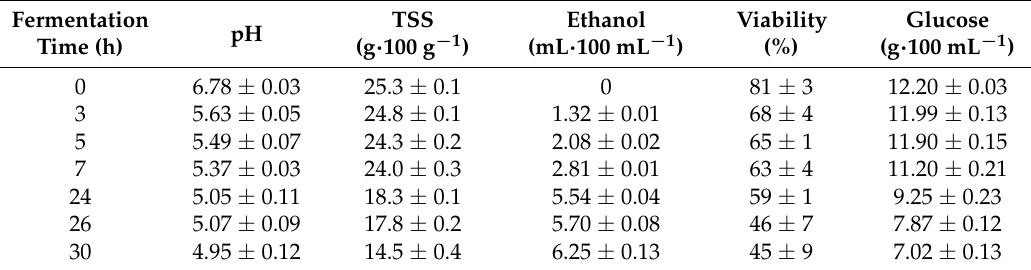
Table 1. Time variation of the fermentation